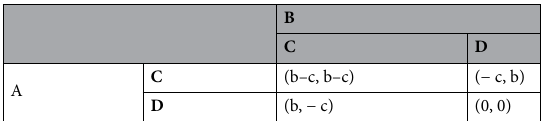
Table 1. Payoff matrix for the Prisoner’s Dilemma (PD) game. We have b = 2 and c = 1 . Payoffs are of the form (Payoff(A), Payoff(B)). If both A and B cooperate, they both pay a cost c , and gain a benefit b from the other’s cooperation. If only one of A or B cooperate, then the defecting agent pays no cost (while the cooperating agent does) and receives only the benefit b . If neither agent cooperates, then nothing is gained or lost.